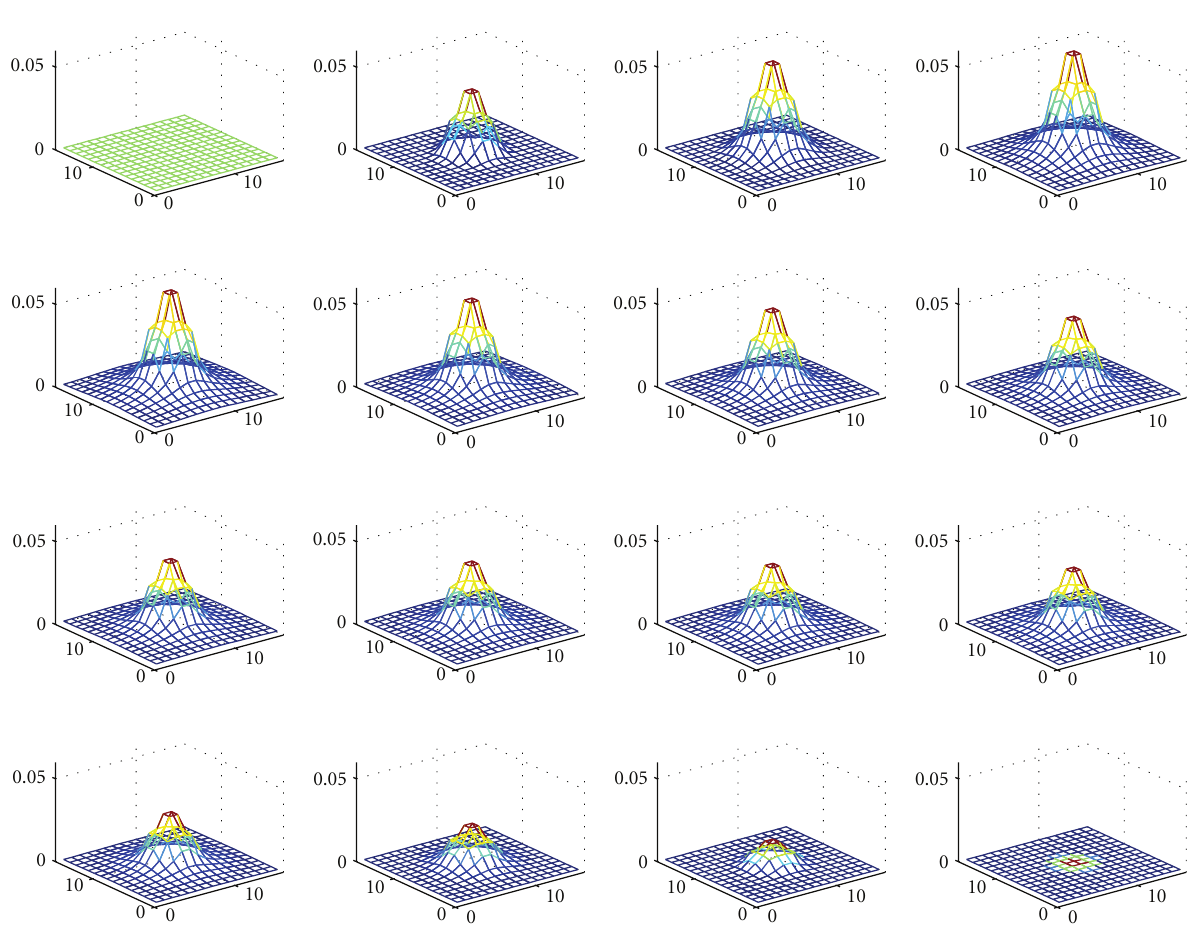
Figure 8: Series of images parameterized by the angle of Compton scattering ω (5 ◦ < ω < 175 ◦ ) (reprinted with permission from